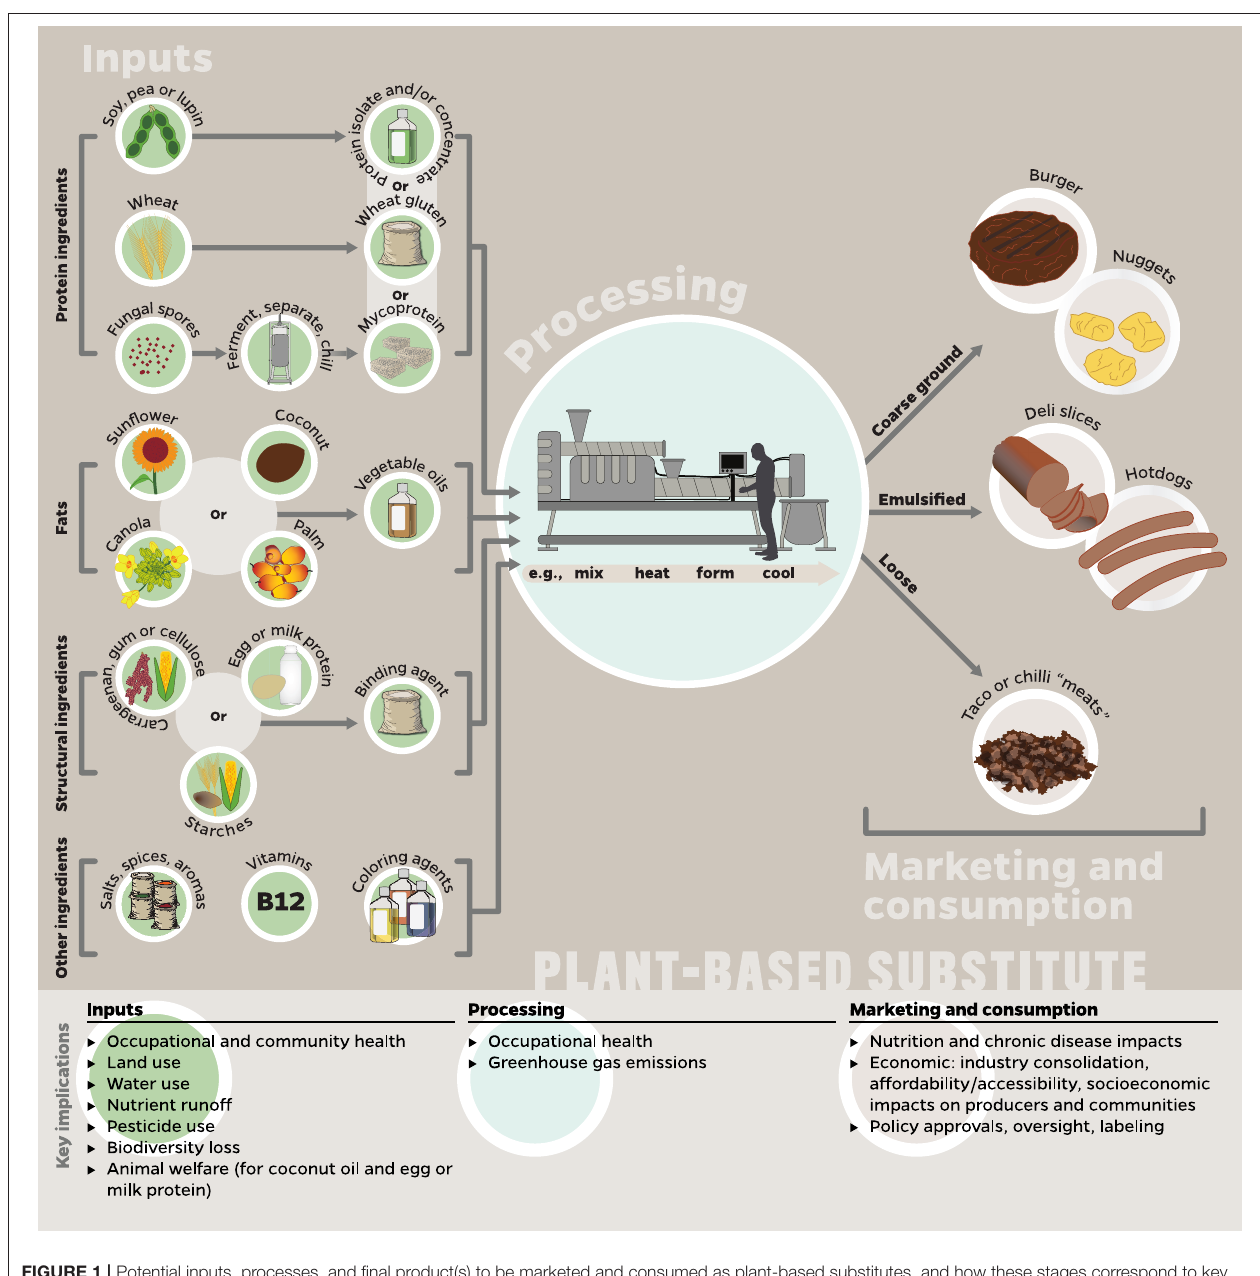
FIGURE 1 | Potential inputs, processes, and final product(s) to be marketed and consumed as plant-based substitutes, and how these stages correspond to key implications explored in this paper. Many of the implications listed here are applicable to multiple stages, e.g., GHG emissions occur in the production of inputs, processing, and retail/consumer stages; however, we listed each implication only with the stage to which it is most relevant or has the greatest impact. The inputs represent a compilation of ingredients included in plant-based substitutes; most products do not contain all of these ingredients at once. This figure was designed by the authors using information reported in Joshi and Kumar (2015), Bohrer (2019), and Kyriakopoulou et al.